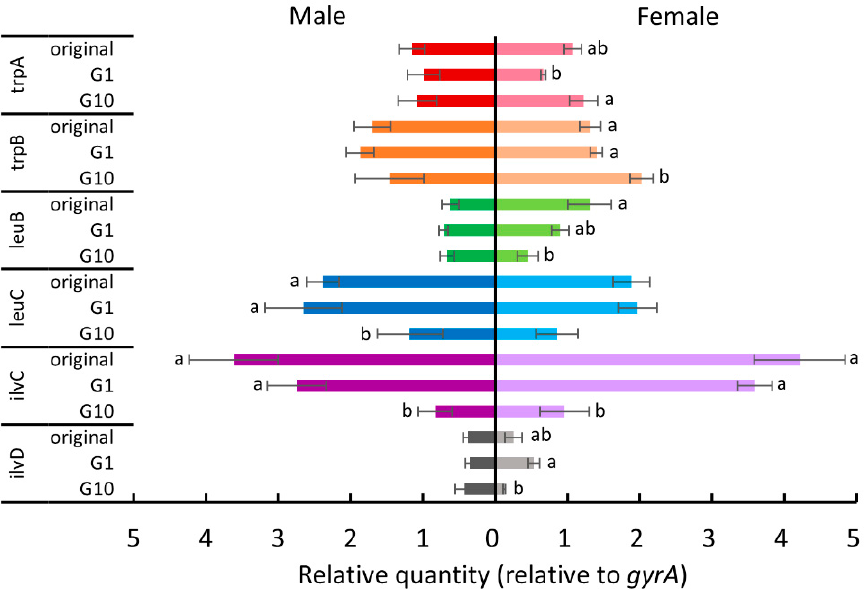
Figure 5. The expression levels of tryptophan, leucine, and isoleucine biosynthesis genes of P. aleyrodidarum in male and female B. tabaci reared on cotton plants in the first and the tenth generations. Expression levels in the original colony are also shown. Horizontal bars indicate standard errors. Different letters indicate significant differences (Tukey test, p < 0.05).